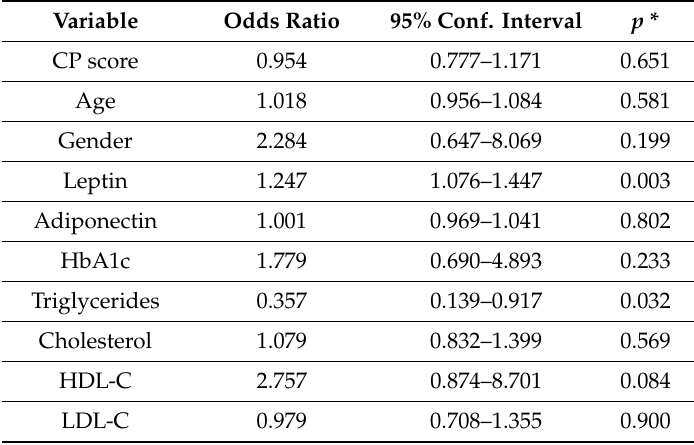
Table 3. Analysis of risk factors for insulin resistance in liver